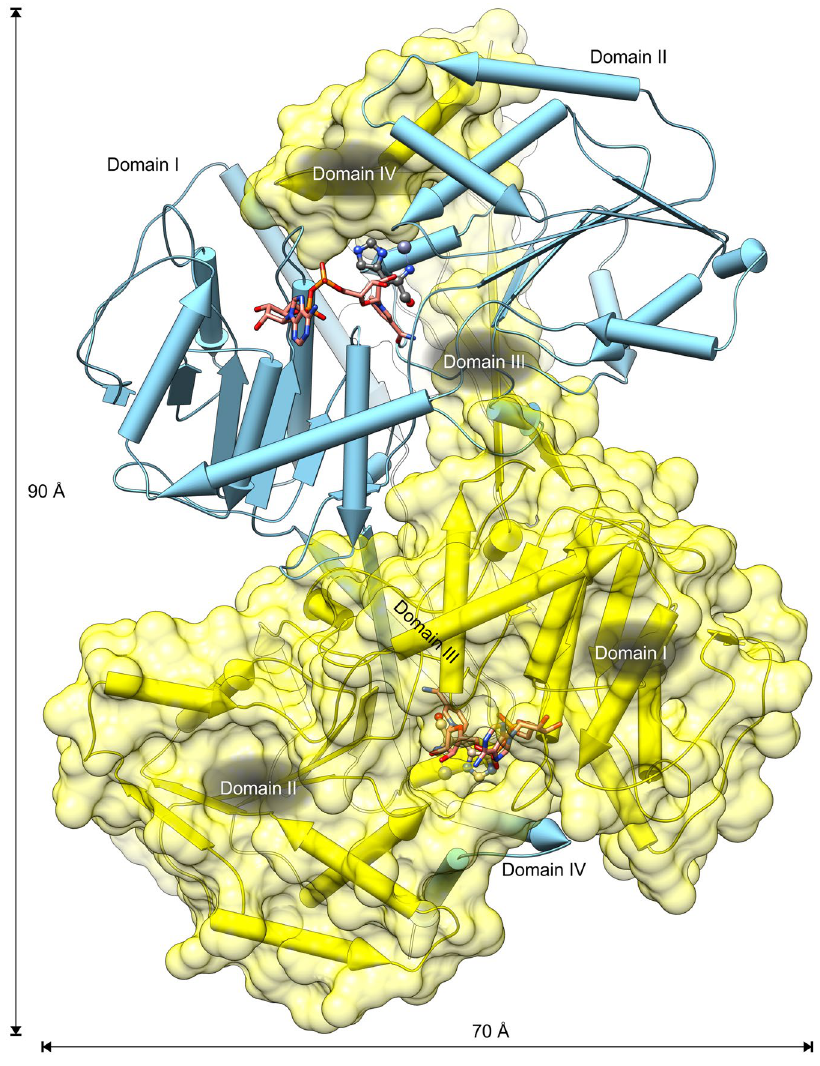
Figure 3. Structure of the Mt HDH homodimer. Chain A, cyan, in pipes-and-planks representation and chain B, yellow, with the protein surface are shown. NAD + and L-histidinol (HOL) from superposed structures show locations of the active sites, one per monomer. White-on-black denotation of domains corresponds to the subunit